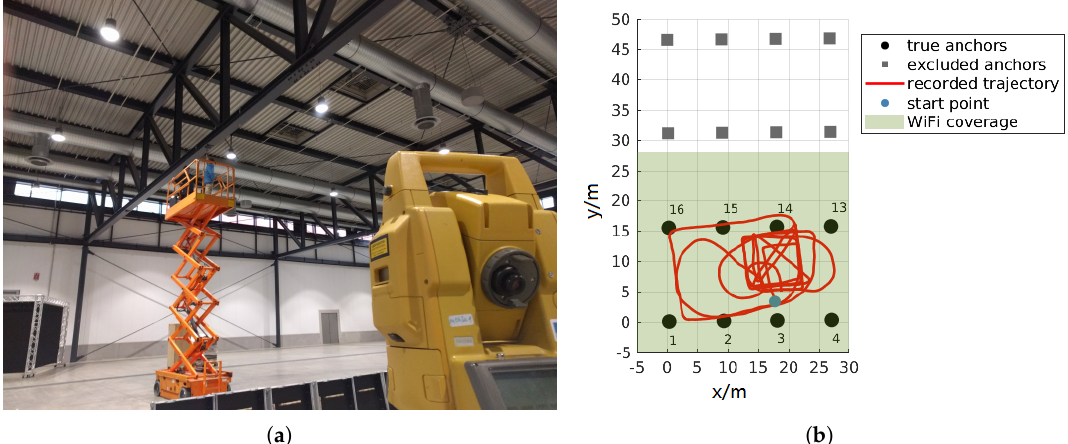
Figure 17. The anchor positions in the exhibition hall 3 of Messe Freiburg with an exemplary trajectory of Exp. 16. Notice the error of about 4m in the start point location: The true start point of the trajectory should be closer to anchor M03 as the beacon was placed directly below this anchor. ( a ) Photo of the anchor node installation at the Messe. ( b ) Anchor positions and Exp. 16 trajectory.